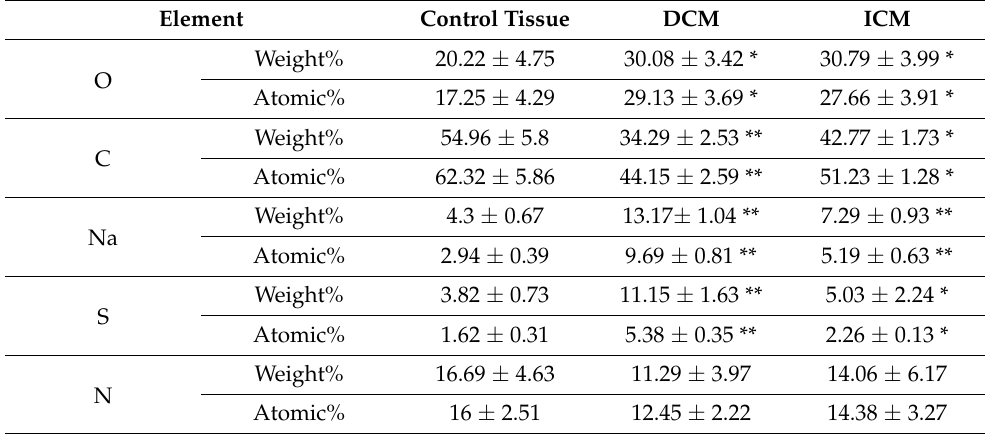
Figure 6. SEM/ED mapping of the mineral deposition in healthy subjects and patients with DCM and ICM. ( A ) SEM image of mineral deposition in HF patients. ( B ) SEM-EDS mapping. ( C ) SEM-EDS elemental analysis. Table 2. Quantification of area spectrum for the weight and atomic percentage of various elements in DCM and ICM. * p < 0.05; ** p < 0.001.